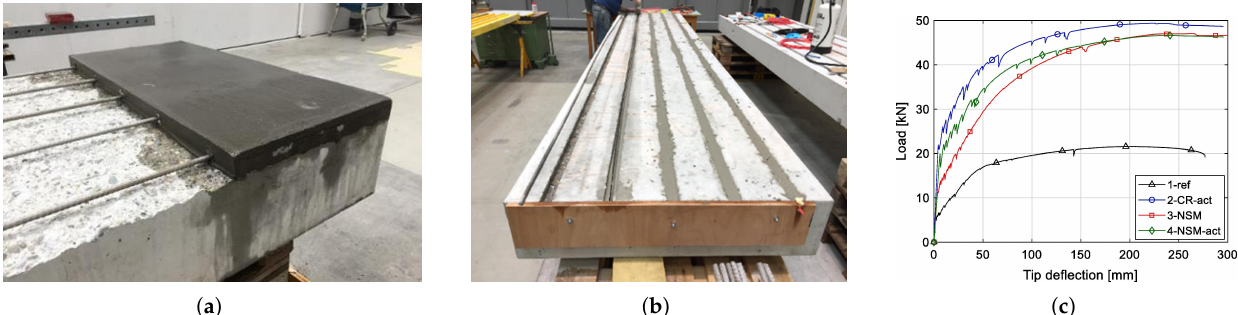
Figure 9. ( a ) First strengthening method; ( b ) second strengthening method; ( c ) load–tip deflection diagram of slabs during quasi-static loading